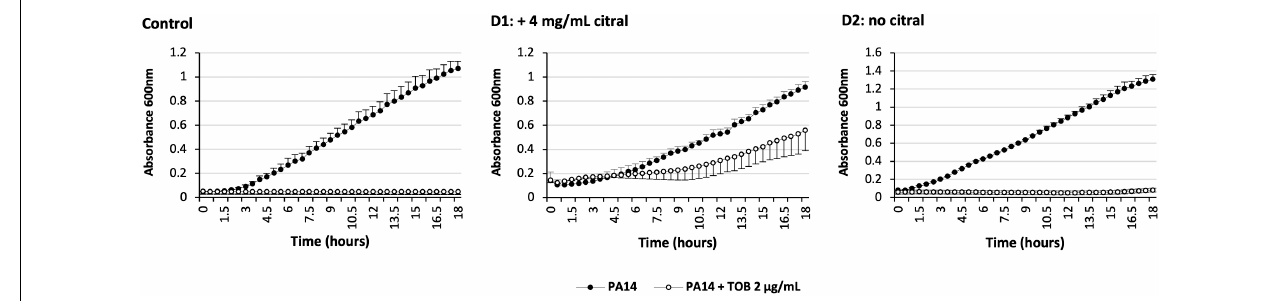
FIGURE 4 | Impact over time of citral on P. aeruginosa susceptibility to tobramycin. Control: PA14 was grown in MHB with (open circle) or without (solid circle) 2 µ g/mL tobramycin (TOB). Day 1 (D1) : PA14 was grown in MHB containing 4 mg/mL citral and complemented or not with TOB. Day 2 (D2) : Tobramycin tolerant cells of D1 (open circle) were grown in a fresh medium without citral, and complemented or not with TOB. The results are presented as mean values calculated from three independent bacterial